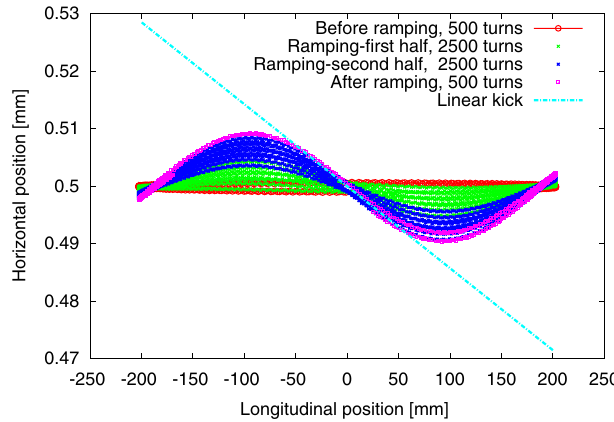
FIG. 17. (Color) Check of crab cavity ramping by tracking reveals a ramp-up time of 5000 turns is sufficiently adiabatic with respect to the synchrotron motion.